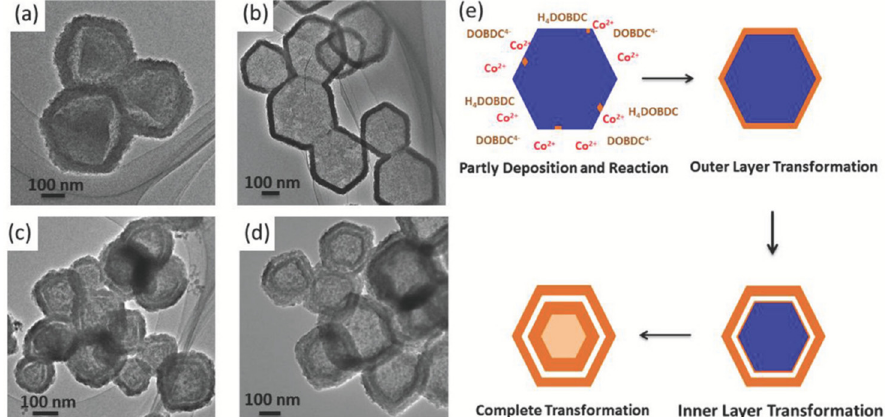
Figure 3. MOF-74-T synthesised in di ff erent conditions (L for H 4 DOBDC, M for ZIF-67): ( a ) n(L) / n(M) Figure 3. MOF ‐ 74 ‐ T synthesised in different conditions (L for H 4 DOBDC, M for ZIF ‐ 67): ( a ) n(L)/n(M) = 0.3, c(L) = 1 × 10 − 3 m; ( b ) n(L) / n(M) = 0.6, c(L) = 0.03 × 10 − 3 m; ( c ) c(L) = 0.25 × 10 − 3 m, n(L) / n(M) = 0.3, c(L) = 1 × 10 − 3 m; ( b ) n(L)/n(M) = 0.6, c(L) =0.03 × 10 − 3 m; ( c ) c(L) = 0.25 × 10 − 3 m, n(L)/n(M) = 2; ( d ) c(L) = 16.7 × 10 − 3 m, n(L) / n(M) = 2. ( e ) Illustration of the transformation strategy process. = 2; ( d ) c(L) = 16.7 × 10 − 3 m, n(L)/n(M) = 2. ( e ) Illustration of the transformation strategy process. Reproduced with permission from [98]. Copyright 2019 Reproduced with permission from [98]. Copyright 2019 Wiley ‐ VCH.